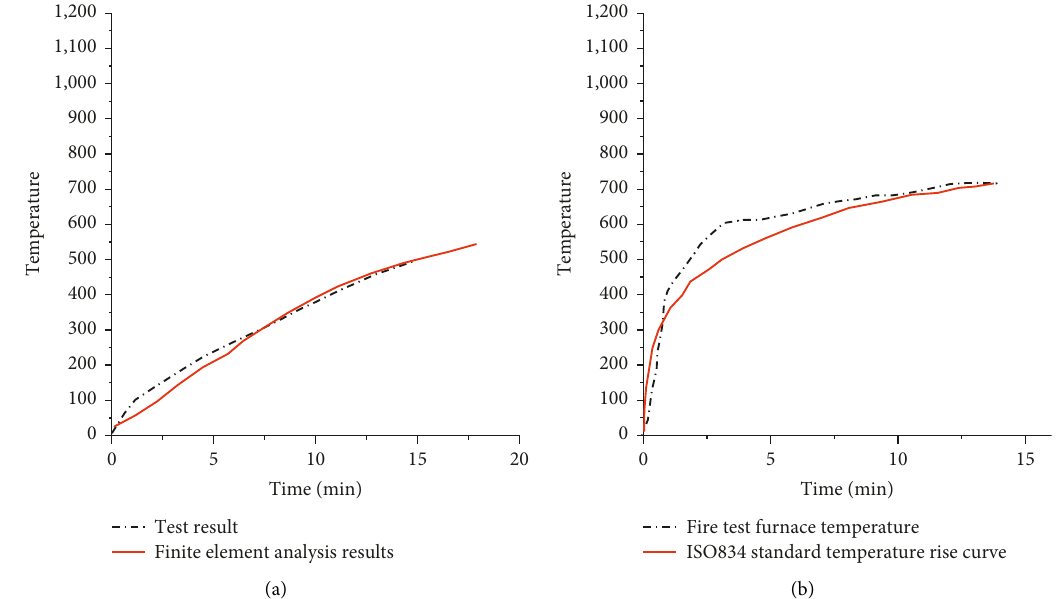
Figure 2: Comparison of temperature field analysis results. (a) Comparison between finite element analysis results and test results; (b) comparison between ISO834 standard temperature rise curve and test furnace temperature.